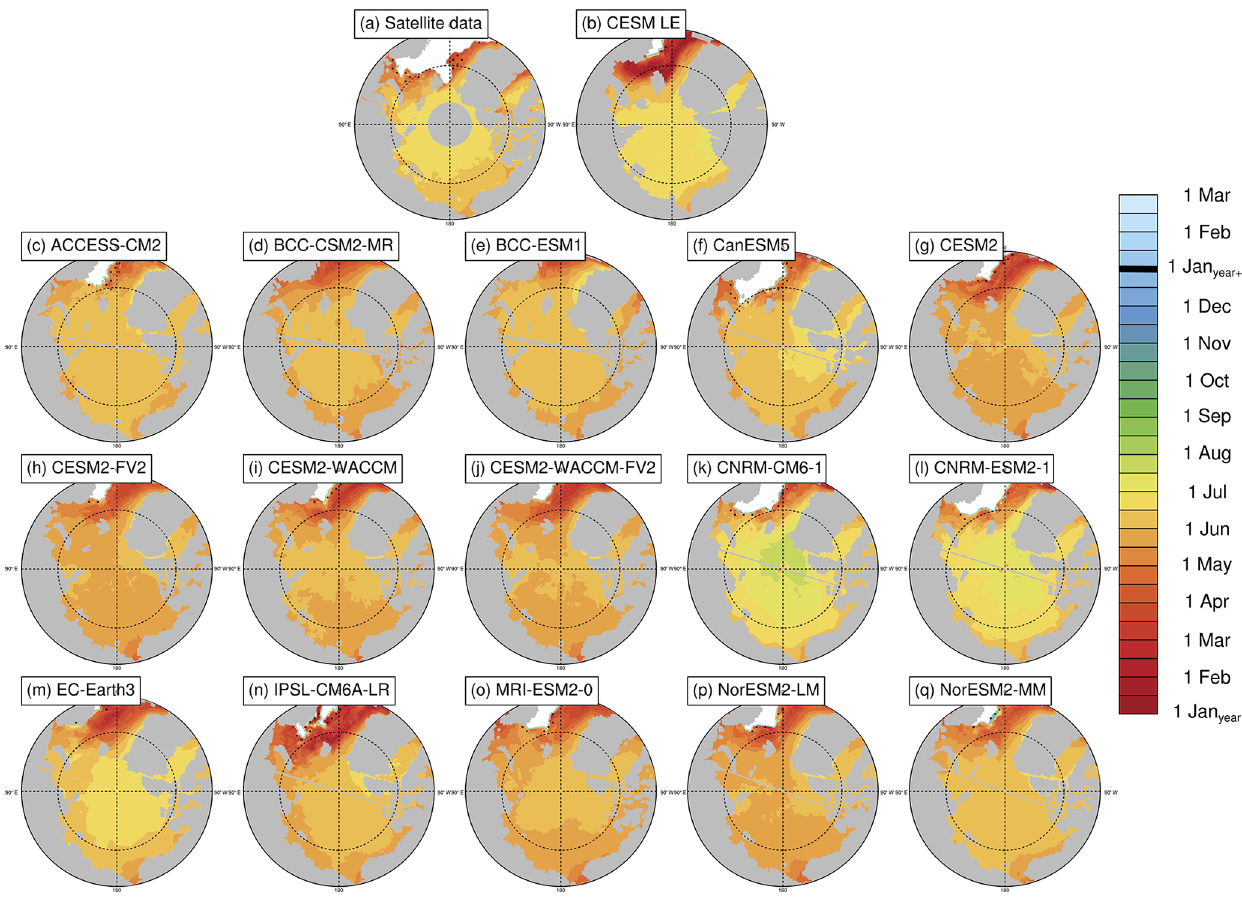
Figure 2. Melt onset dates (defined using surface temperature in the models and brightness temperatures in the satellite data) averaged over the period 1979–2014 at each grid cell using satellite data (a) , the first ensemble member of the CESM LE (b) , and the first ensemble member of each CMIP6 model (c–q) . Stippling indicates where melt onset dates exist in less than 20% of years in the time range. Models on tripolar grids produce plot gaps filled by gray